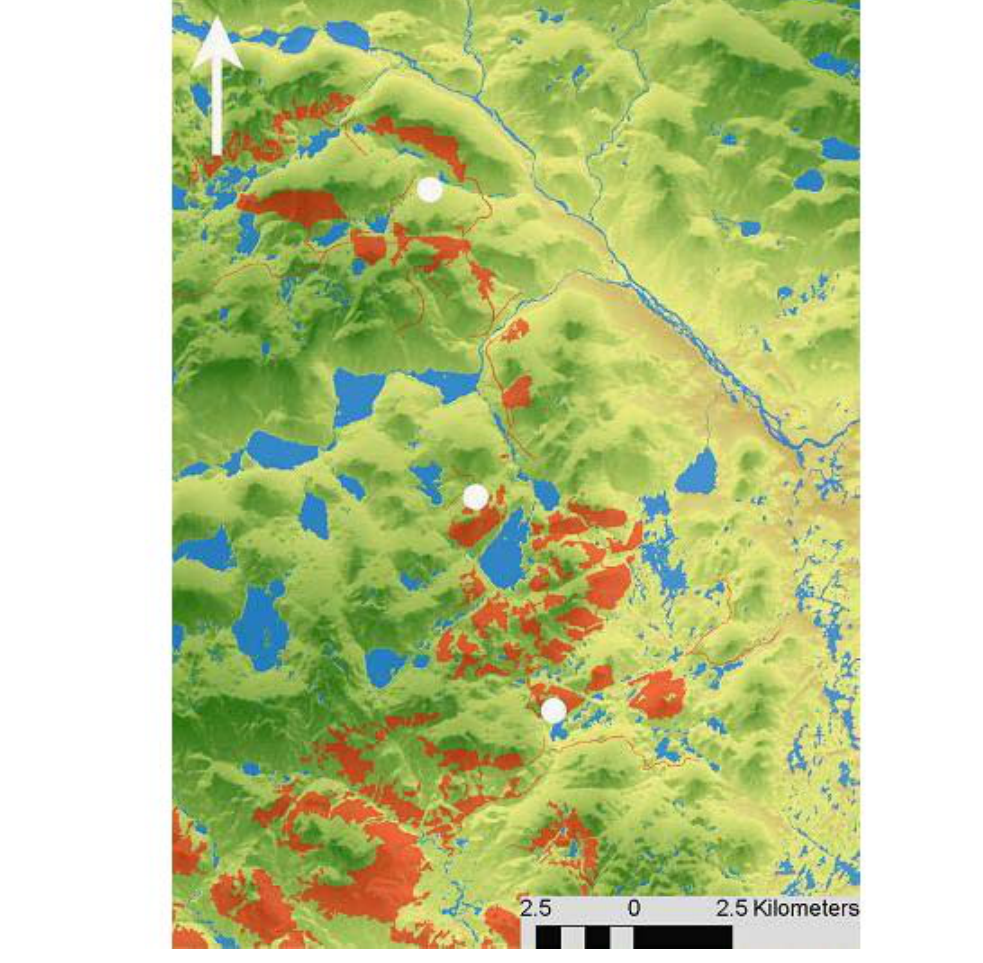
Fig. 1. Digital elevation model and locations (white circles) of study sites in northwestern Newfoundland. Study sites are the locations where birds were initially captured and fitted with radio transmitters. Dark green and brown areas represent high and low elevation habitat, respectively. Red areas represent clearcut land cover. Blue areas represent lakes and first- and second-order rivers. North is located at the top of the map (depicted by the white